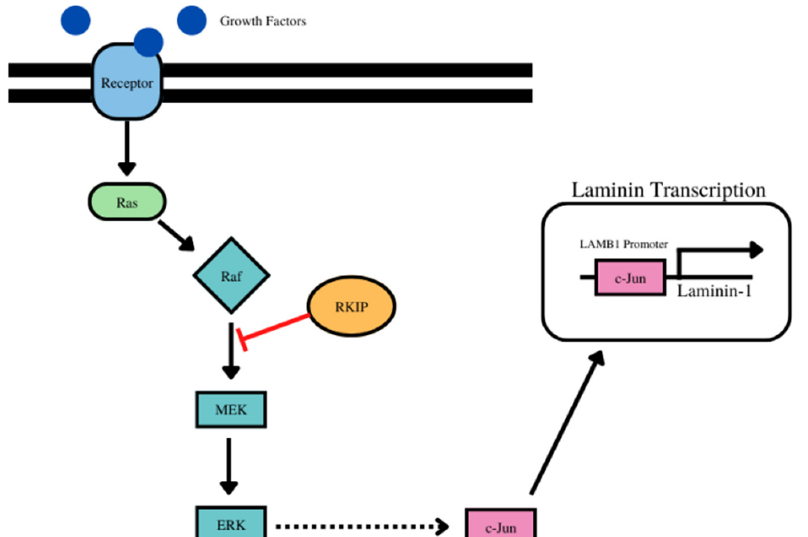
Figure 6. Crosstalk Between RKIP and Laminin. RKIP inhibits the MEK/ERK signaling pathway by interrupting the interaction between Raf and MEK, stopping the progression of the signal through the pathway. C-Jun is regulated downstream of the MEK/ERK pathway. C-Jun binds to the promoter of Laminin-1, regulating the expression of Laminin-1.